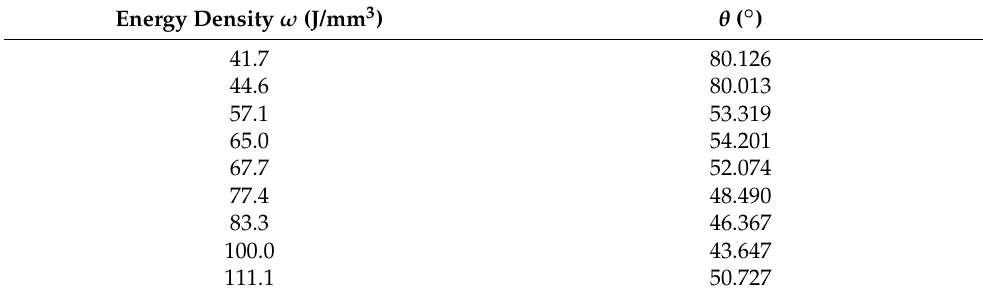
Table 4. Theta angle between the grain and boundary tangent for different energy densities.